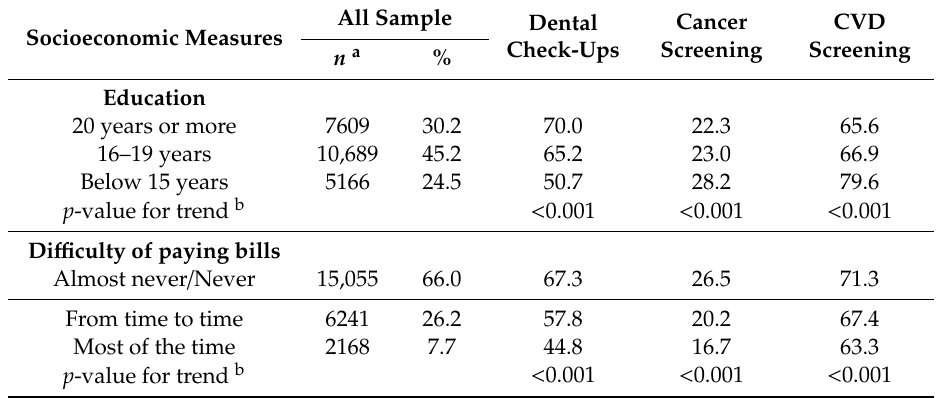
Table 2. Crude socioeconomic inequalities in use of dental and medical preventive services among adults aged 20 + years old in European Union countries ( n =